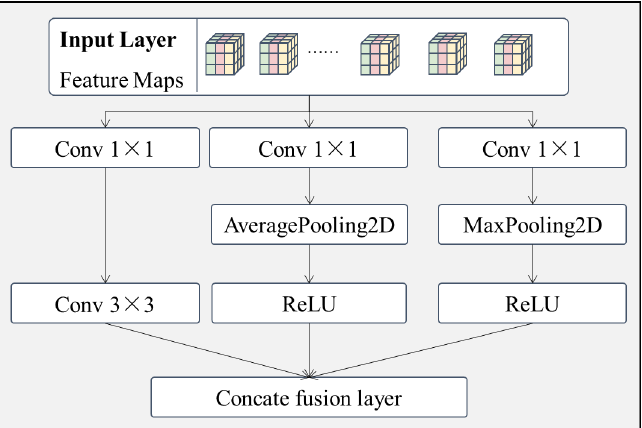
Figure 4. Structure of the Max-AVG pooling feature extraction